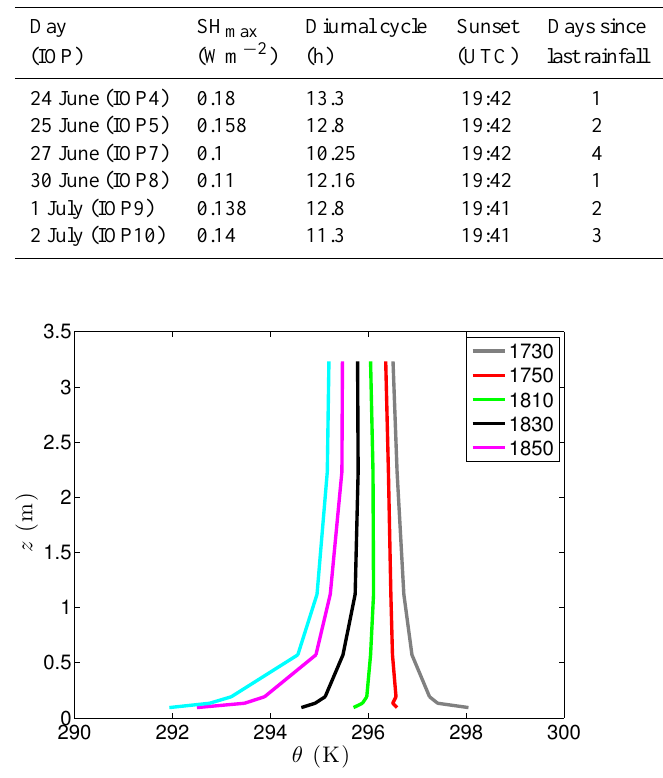
Figure 2. Observed 5min averaged vertical profile of potential tem- perature during the evening transition on 1 July 2011.